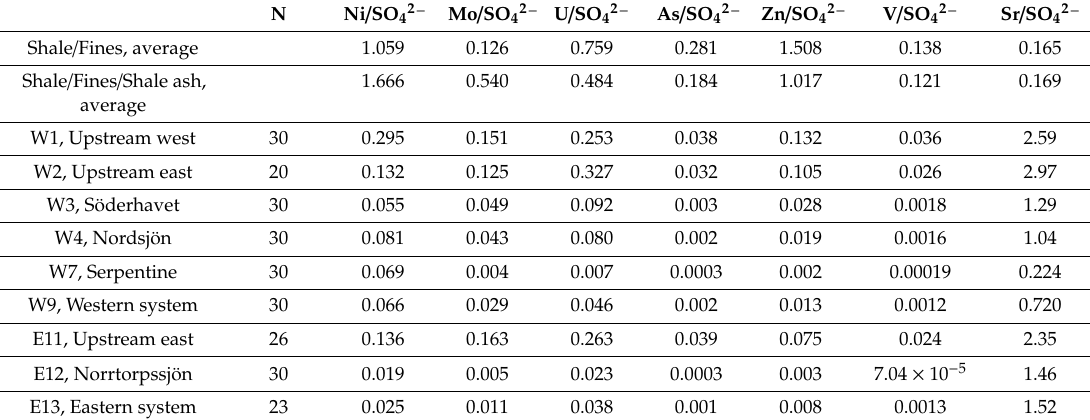
Table 8. Trace element / sulfate ratios ( µ g / L / mg / L) for upstream and downstream sampling points compared to the average ratios obtained from leaching tests of solid waste materials (shale, fines and shale ash). N Ni / SO 42 − Mo / SO 42 − U / SO 42 − As / SO 42 − Zn / SO 42 − V / SO 42